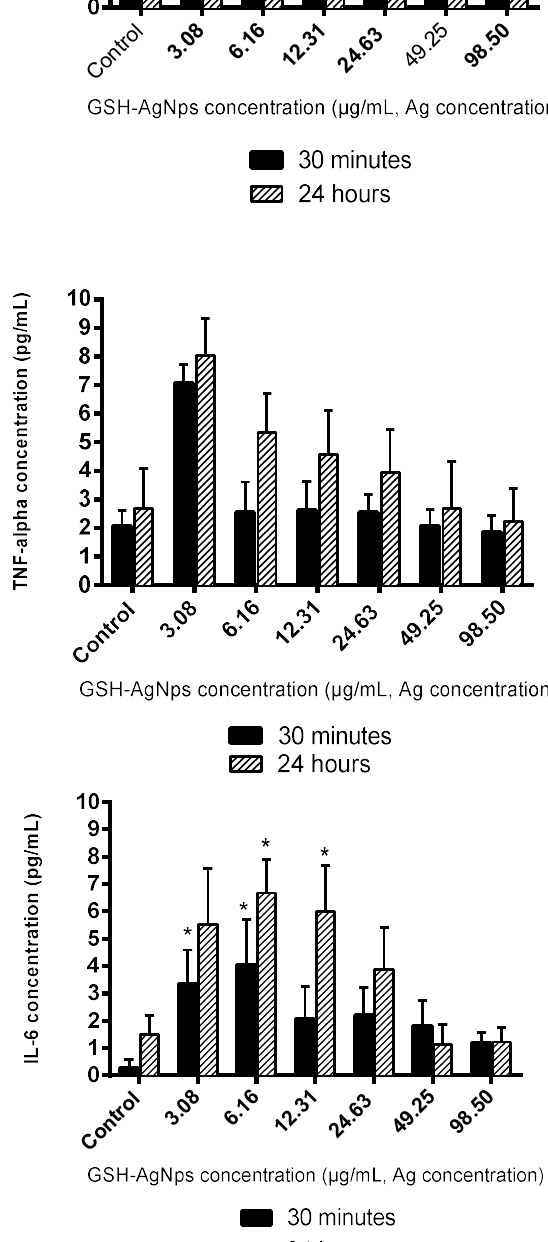
Figure 4. Production of cytokines (IL-8, TNF- α , and IL-6) (pg / mL) in HGF-1 cells after exposure for 30 min and 24 to GSH-AgNPs. Results are presented as mean ± standard deviation. * Significant differences respect to the control ( p < 0.01).